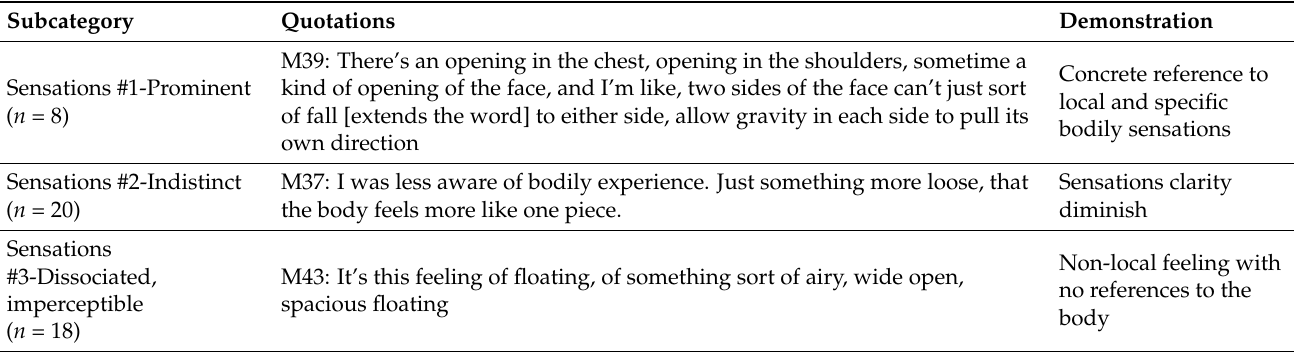
Table 10. SB − representative examples of body